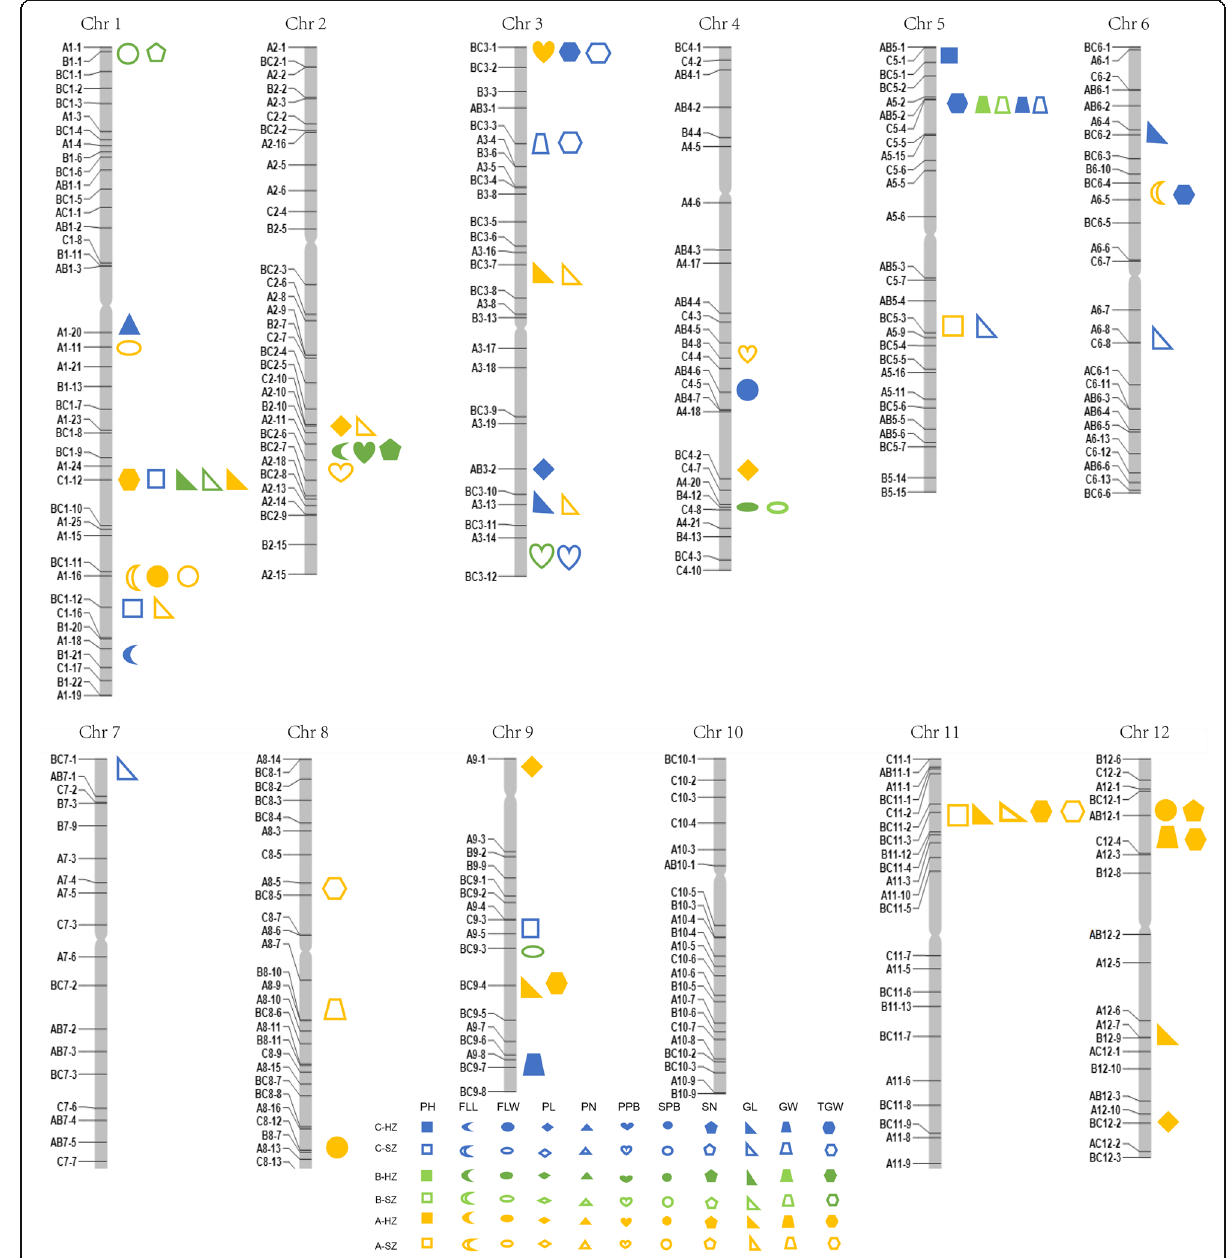
Fig. 4 The positions of QTLs located on each chromosome. Markers for CSSLs development are shown in left. HZ and SZ represent Hangzhou and Shenzhen,